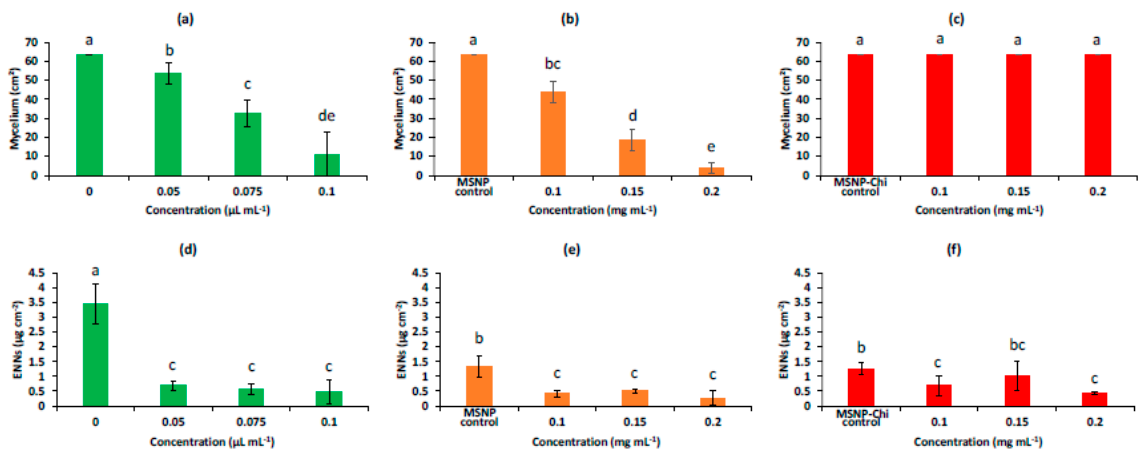
Figure 9. Effects in agar dilution assays of free AP-EO, (green bars, ( a , d )), AP-EO/MSPs (orange bars, ( b , e )), and AP-EO/MSPs-Chi (red bars, ( c , f )) on mycelial growth ( a – c ) and on the ENN production presented as the sum of ENNA, ENNA1, ENNB, and ENNB1 ( d – f ) of F. avenaceum . Controls in ( b , e ) are silica particles (MSPs) at 0.1 mg g − 1 . Controls in ( c , f ) are MSPs coated with chitosan at 0.1 mg g − 1 . Values are means of triplicates. Error bars are ± standard deviation (SD). Means with the same lowercase letter are not significantly different ( p < 0.05).